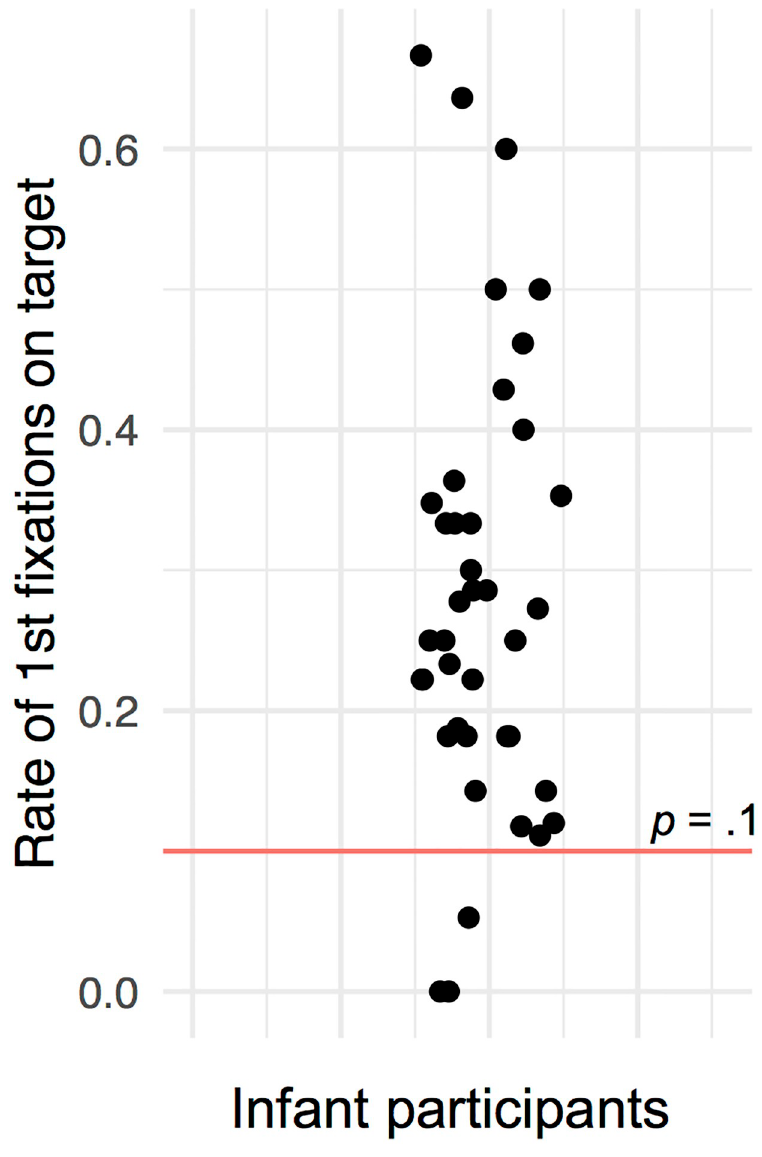
Fig 6. First fixations on areas of interest including the target. Points indicate the rate of an infant’s number of first fixations on targets relative to the number of the first fixations on any of the 10 possible target locations (AOIs), independent of their including the target or not (rates: Md = .25, sd = .16, range = 0 to .67). The red line indicates the chance-level of a first fixation on a particular target location, if only fixations within the AOIs are considered. Points are scattered sideways to avoid